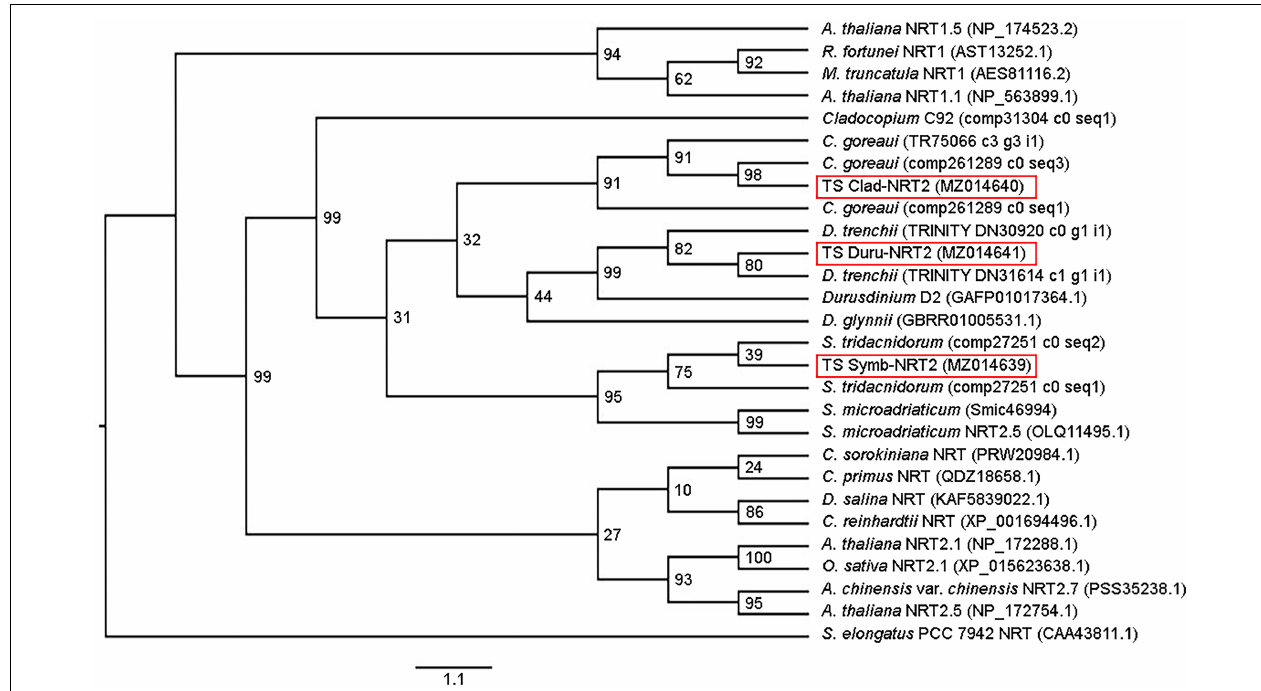
FIGURE 2 | Phenogramic analysis of nitrate transporter 2 from Symbiodinium (Symb-NRT2), Cladocopium (Clad-NRT2), and Durusdinium (Duru-NRT2) from the outer mantle of Tridacna squamosa . Numbers at each branch point represent bootstrap values from 2000 replicates. NRT from Synechococcus elongatus is used as the outgroup. Amino acid sequences of nitrate transporters from algae ( Chlamydomonas reinhardtii , Chlorella sorokiniana , Chloropicon primus , Cladocopium C92, C. goreaui , Dunaliella salina , Durusdinium D2, D. glynnii , D. trenchii , Symbiodinium tridacnidorum , and S. microadriaticum ) and higher plants ( Actinidia chinensis var. chinensis , Arabidopsis thaliana , Medicago truncatula , Oryza sativa , and Rhododendron fortunei ) were obtained from Genbank or various dinoflagellate databases with their accession or contig numbers given in